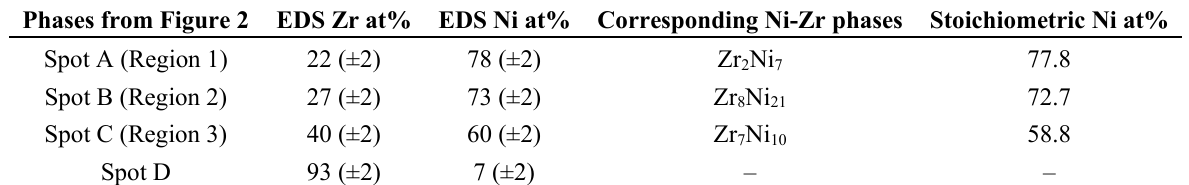
Figure 2. Integrated Zr-L α 1 EDS map (green), Ni-K α 1 EDS map (red), and SEM secondary electronic image (gray scale), showing different phases in the sample, including Region 1 (Zr 2 Ni 7 ), Region 2 (Zr 8 Ni 21 , the major phase), and Region 3 (Zr 7 Ni 10 ). Table 1. Comparison between the EDS measured Ni-Zr composition ratio and the composition from the corresponding stoichiometric